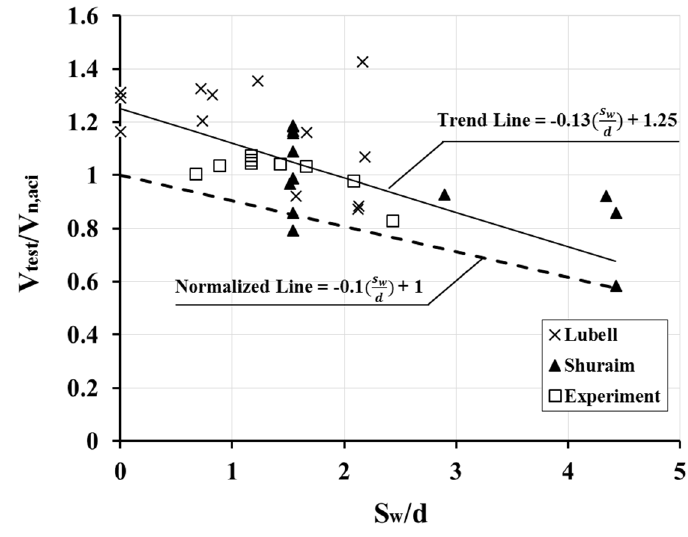
Figure 8. Distribution map of specimens with various transverse spacing.